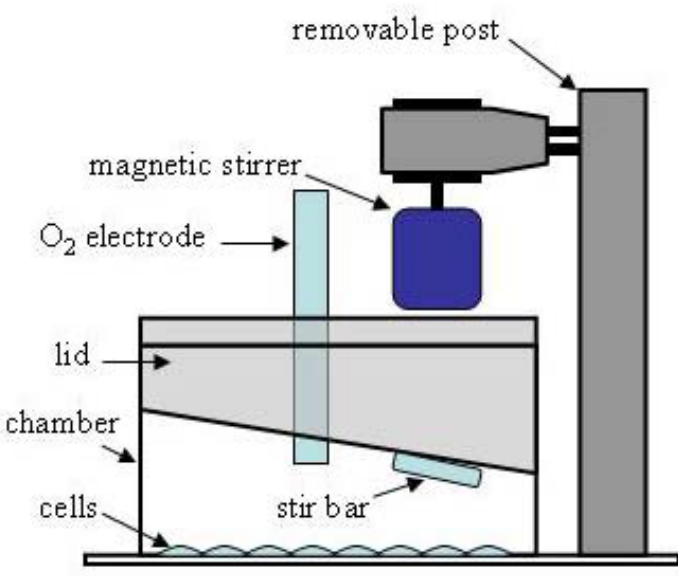
Figure 2. Schematic diagram of a batch-mode approach to measuring the respiration rate of attached cells.